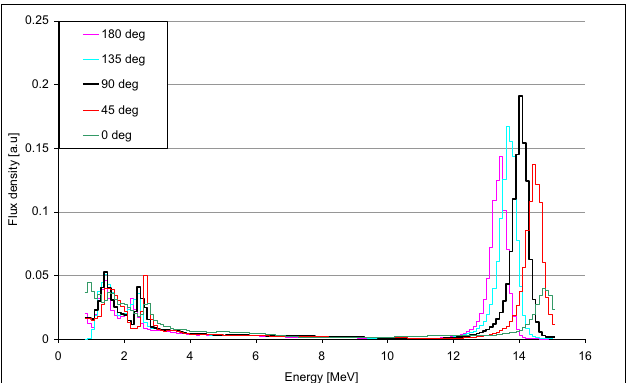
Figure 4. Neutron spectra in various angles from the Ostrava D-T generator.